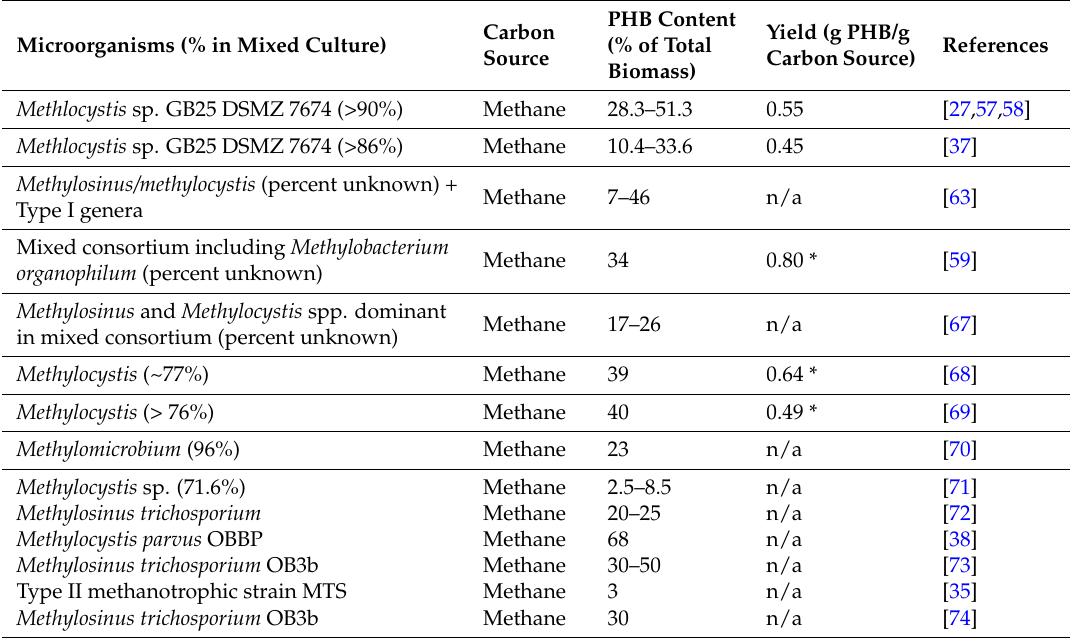
Table 1. Summary of the methylotrophic and methanotrophic production of PHB. Adapted from Khosravi-Darani et al. [66] and Karthikeyan et al.